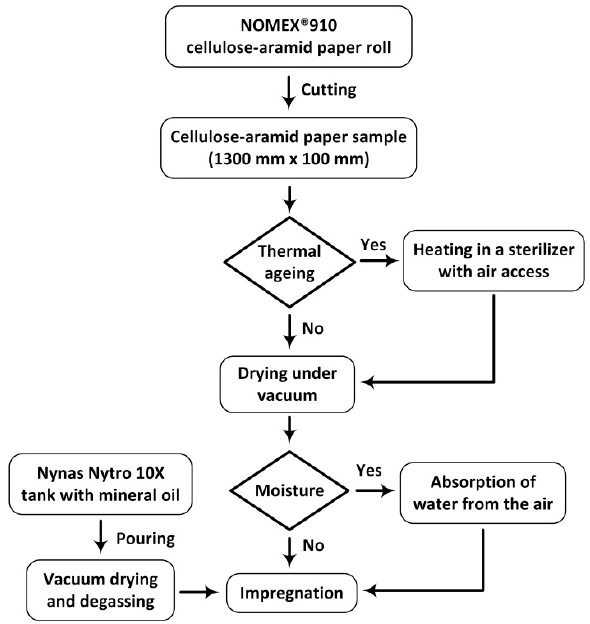
Figure 2. Sample preparation diagram.